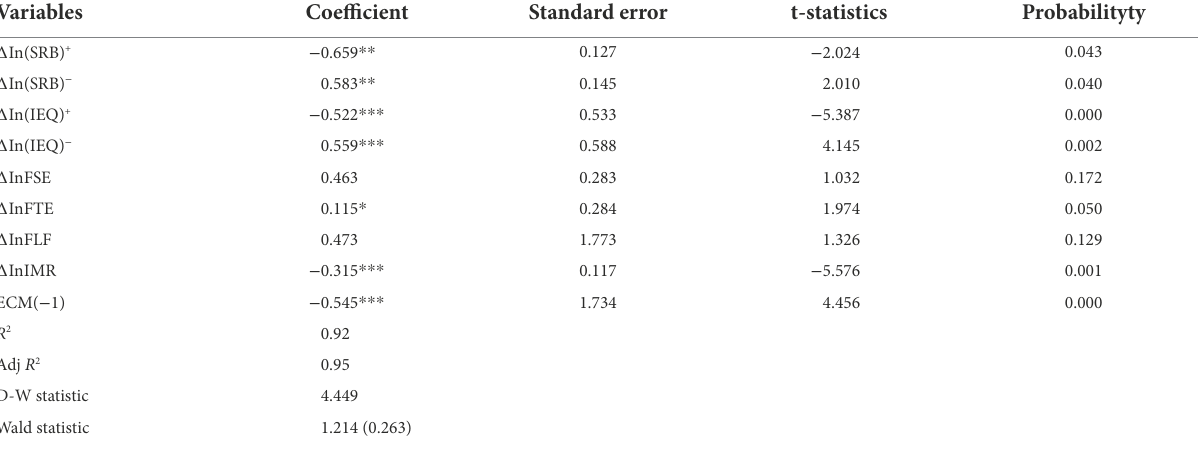
TABLE 6 NARDL short-term variable elasticities results (Dependent variable: